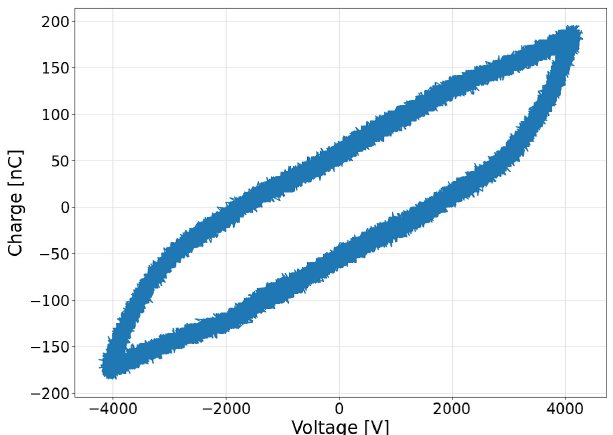
Figure 6. VQ Lissajous curve for the measurement of supplied power from the small power supply to 1 m DBDPA with an approximately 0.2 m